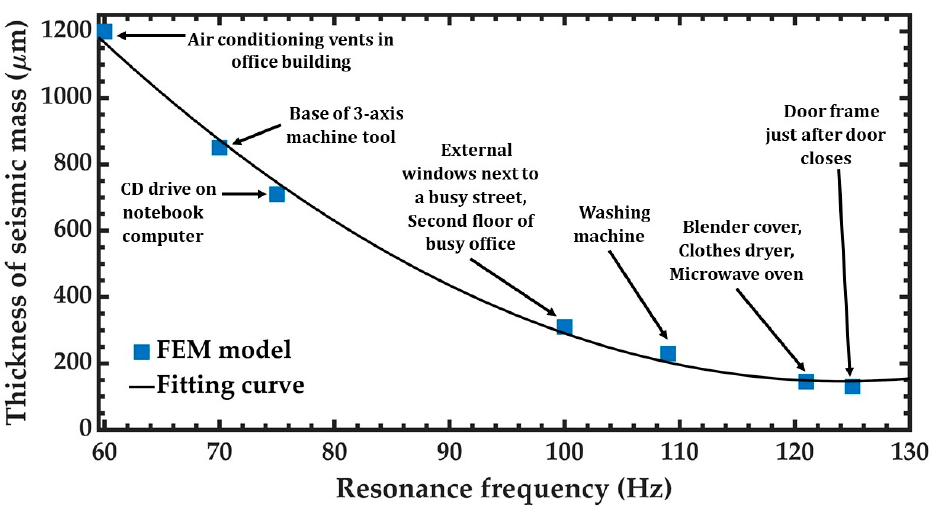
Figure 14. Schematic view of the variation of the resonant frequency of the pVEH microdevice caused by the modification of the thickness of seismic mass. Different applications of the pVEH microdevice can be obtained adjusting the thickness of seismic mass.